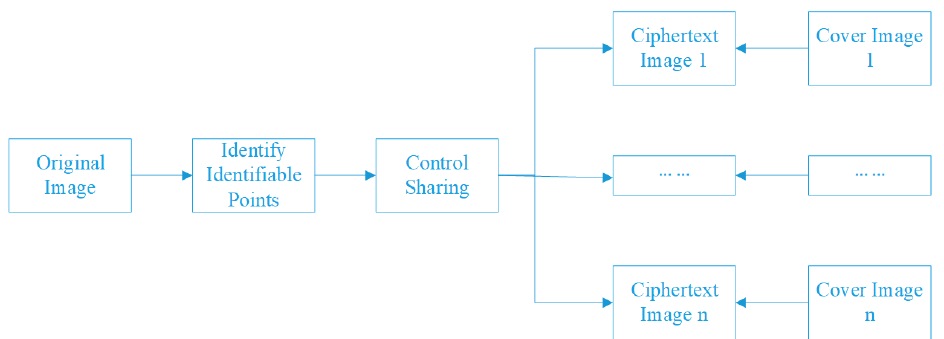
Figure 4. Flow chart of our